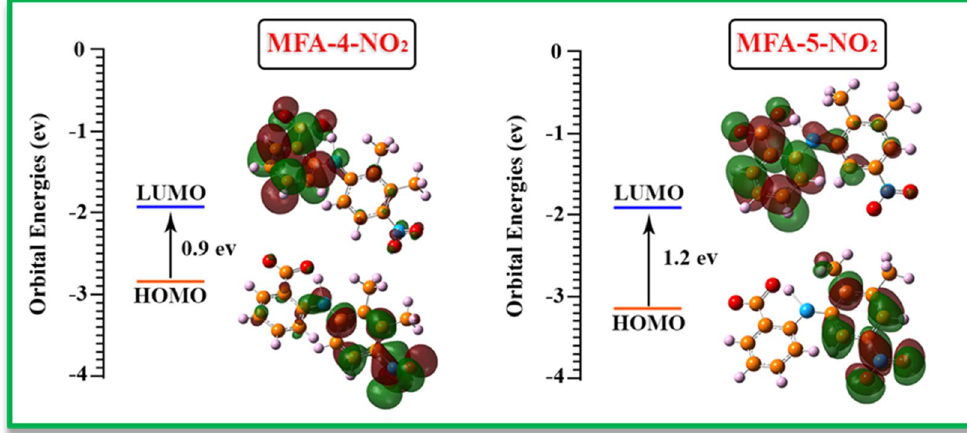
Figure 15. HOMO–LUMO energy gaps of possible intermediates.